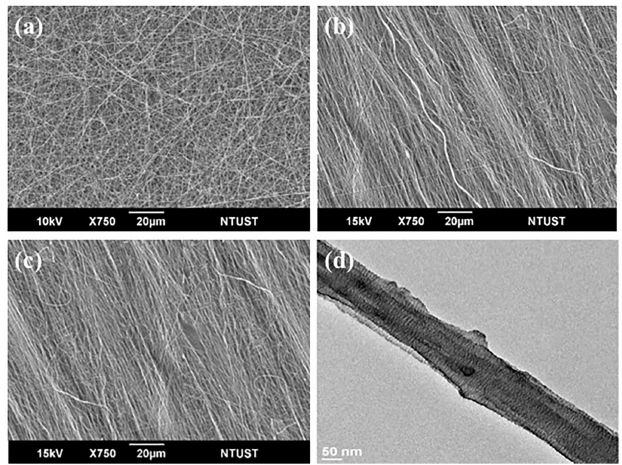
Figure 1. SEM images of: ( a ) randomly oriented electrospun PVDF; ( b ) aligned electrospun PVDF; and ( c ) aligned electrospun PVDF/CNT. ( d ) TEM image of aligned electrospun PVDF/CNT